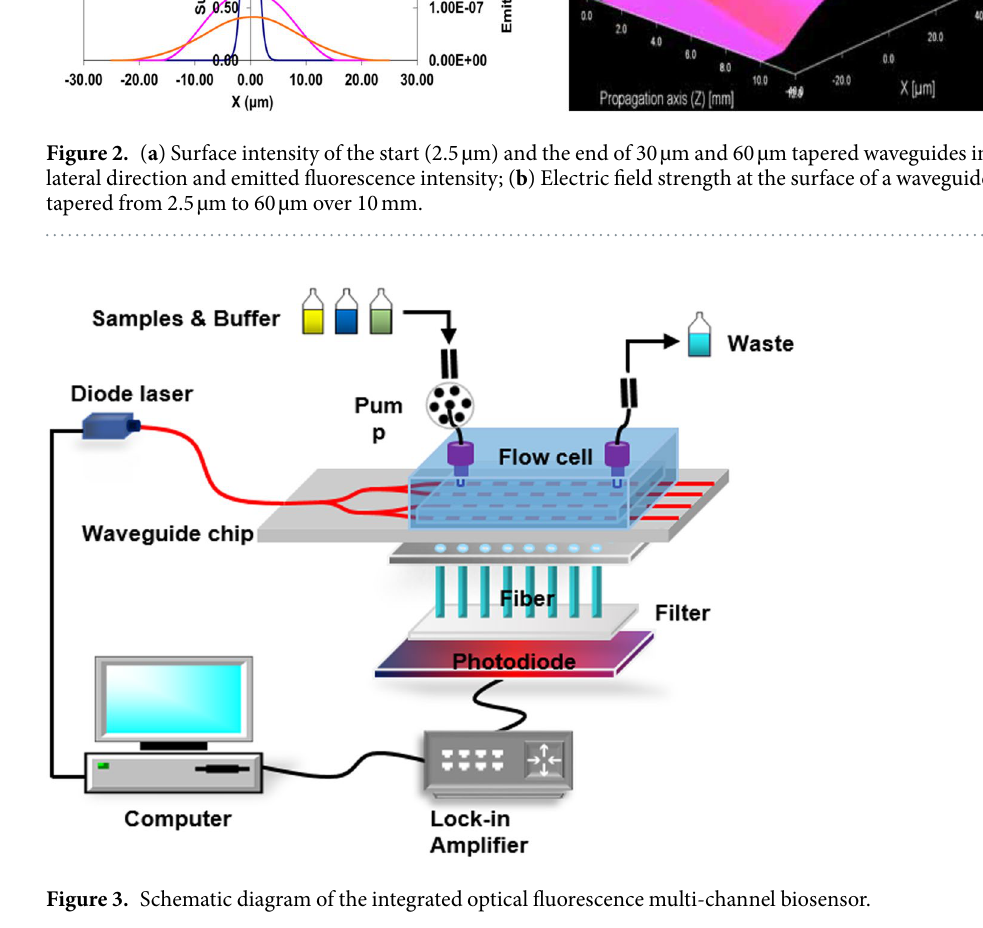
Instrumentation. Figure 3 illustrates the experimental configuration of the multi-channel waveguide-based fluorescent evanescent wave biosensing platform. Briefly, light from a semiconductor laser emitting approxi- mately 5 mW at 635 nm is coupled to the fibre-pigtailed multi-channel ion-exchange waveguide. The emitted